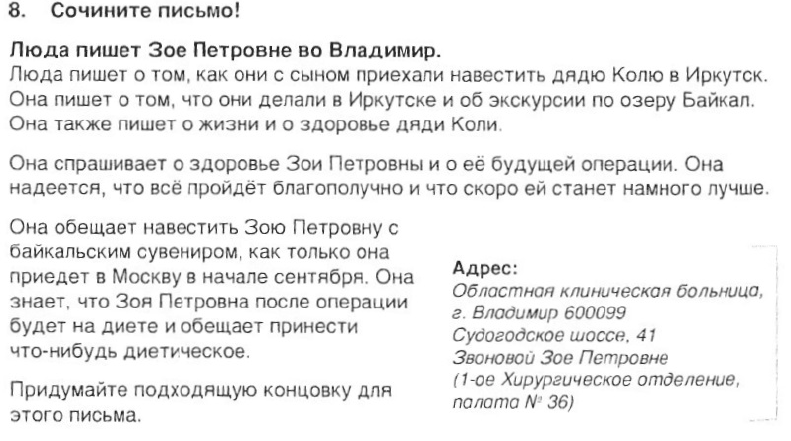
Figure 6. Example 2 of a task in Molodets .